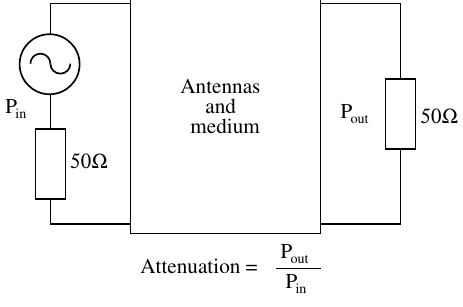
Figure 6. Attenuation